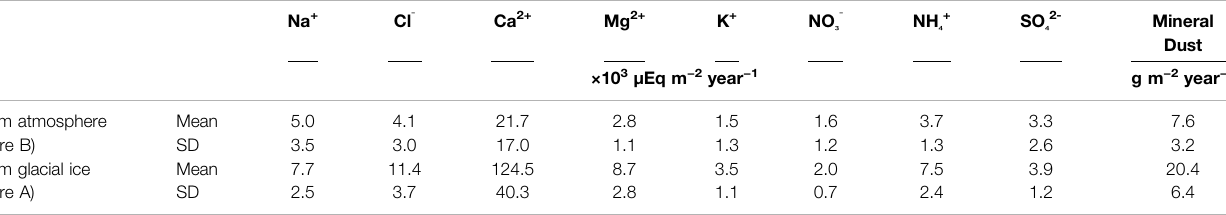
TABLE 3 | Annual fl uxes of chemical solutes and mineral dust (d > 5 μ m) from the atmosphere and from the glacial ice estimated by ice cores analyzed in this study.